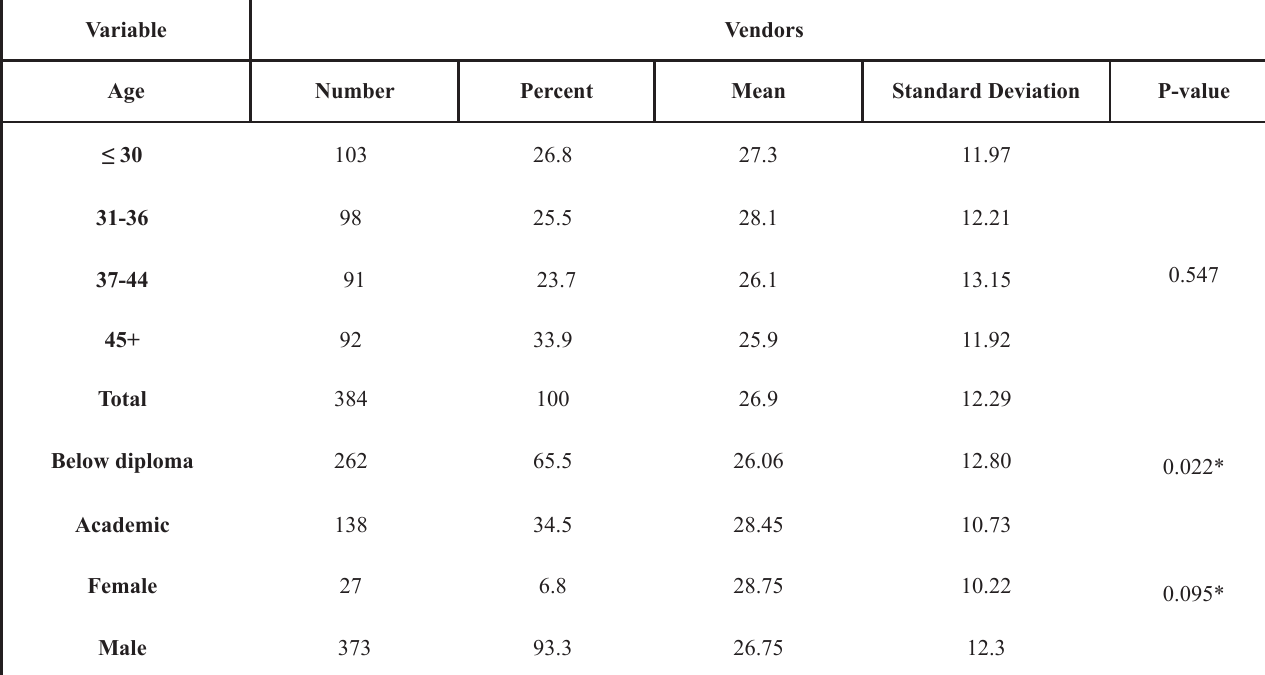
Table 1. Demographic characteristics of